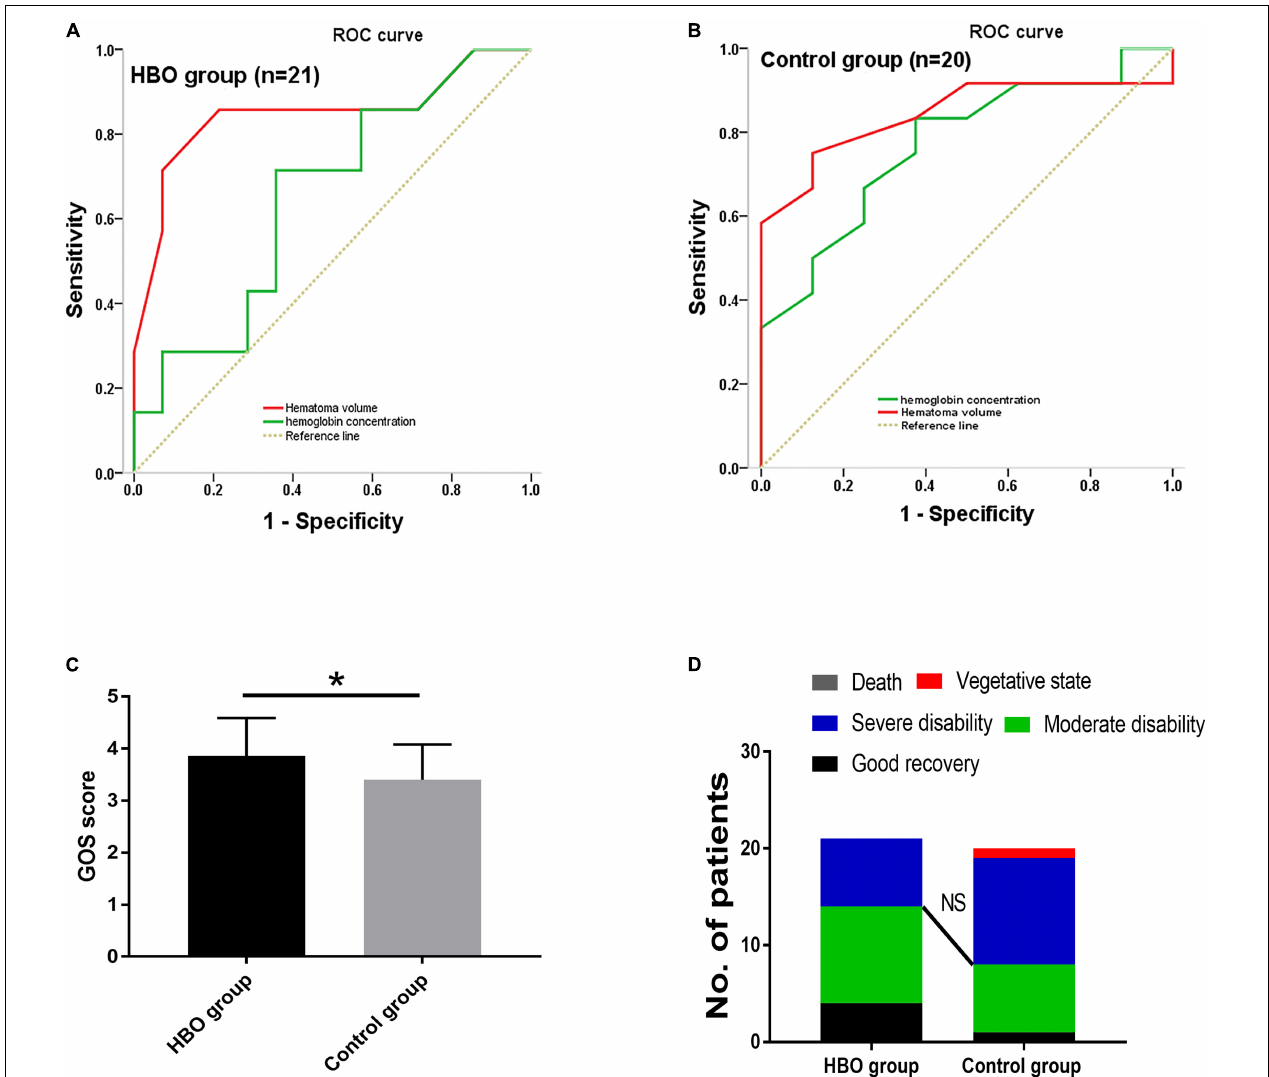
FIGURE 5 | ROC curve analysis was used to determine the cutoff values for hematoma volume and hemoglobin concentration in predicting the outcome after surgery. Specificity and sensitivity were used as measures of outcome accuracy. Analyses were performed in the HBO group (A) and the control group (B) . The outcome was estimated using the area under the ROC curve (AUC). The GOS scores of the HBO and control groups were obtained 6 months after cerebral hemorrhage and were significantly higher in the HBO group than in the control group (C) . However, NS indicates that there was no significant difference in the percentage of good outcomes between the groups (D) . Statistically significant differences, indicated by * P <